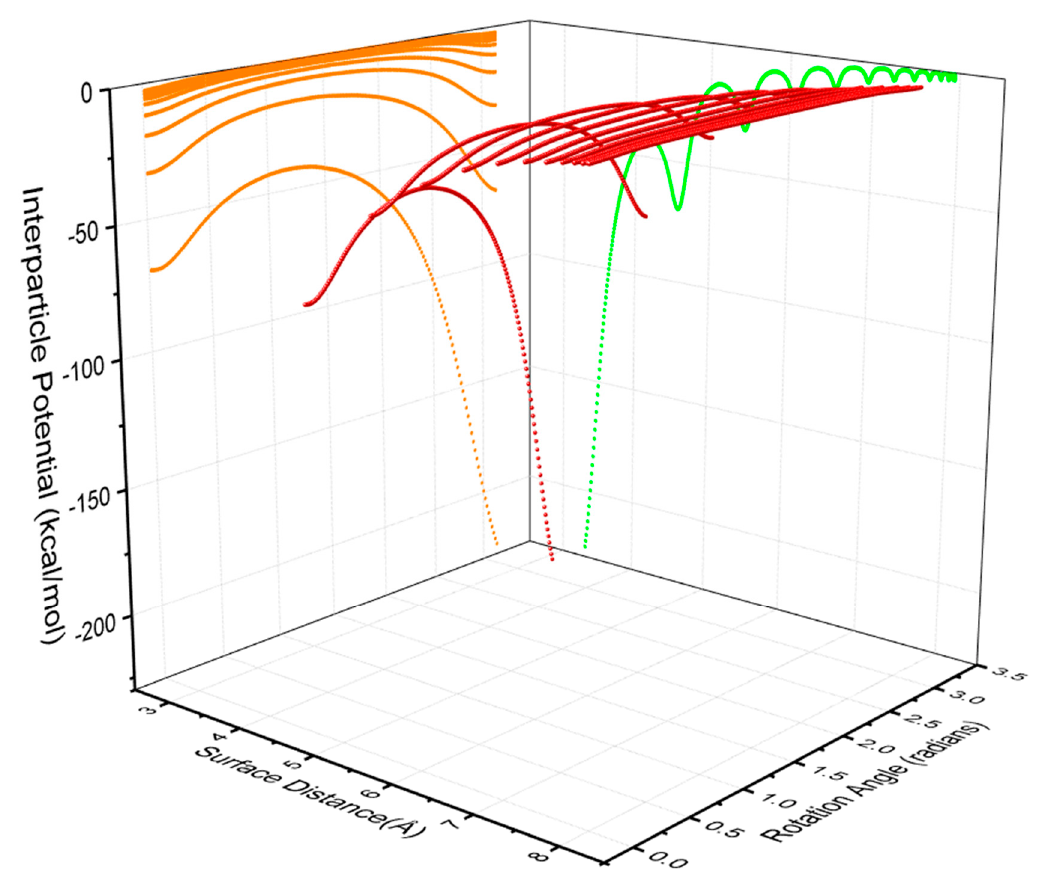
Figure 4. 3D illustration of interparticle potential (in red) as a function of surface separation and rotation angle in radians of a pairwise AuNRs with a diameter of 2 nm and aspect ratio of 4. The projected curves indicate the dependence of potential on rotation angle (in amber) and surface separation (in green), respectively.